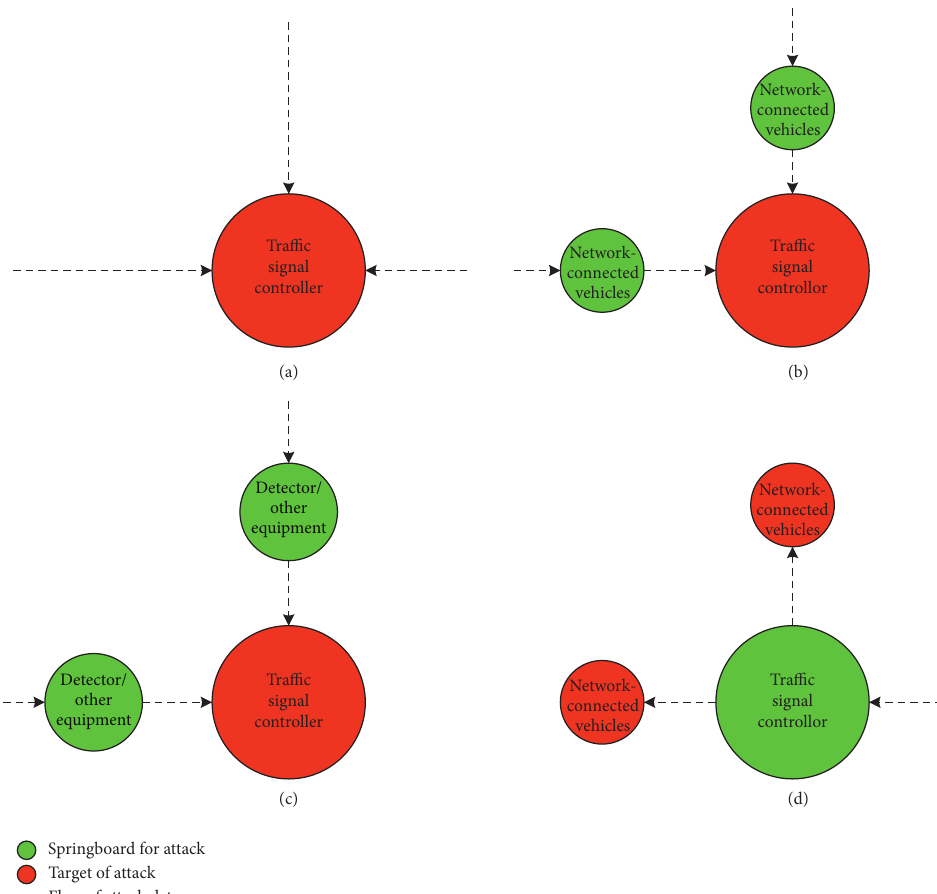
Figure 9: Classification of information security attack scenarios of traffic field equipment.